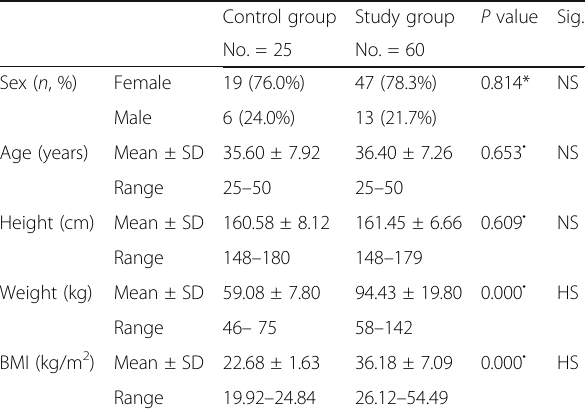
Table 1 General characteristics and anthropometric measures of control group and study